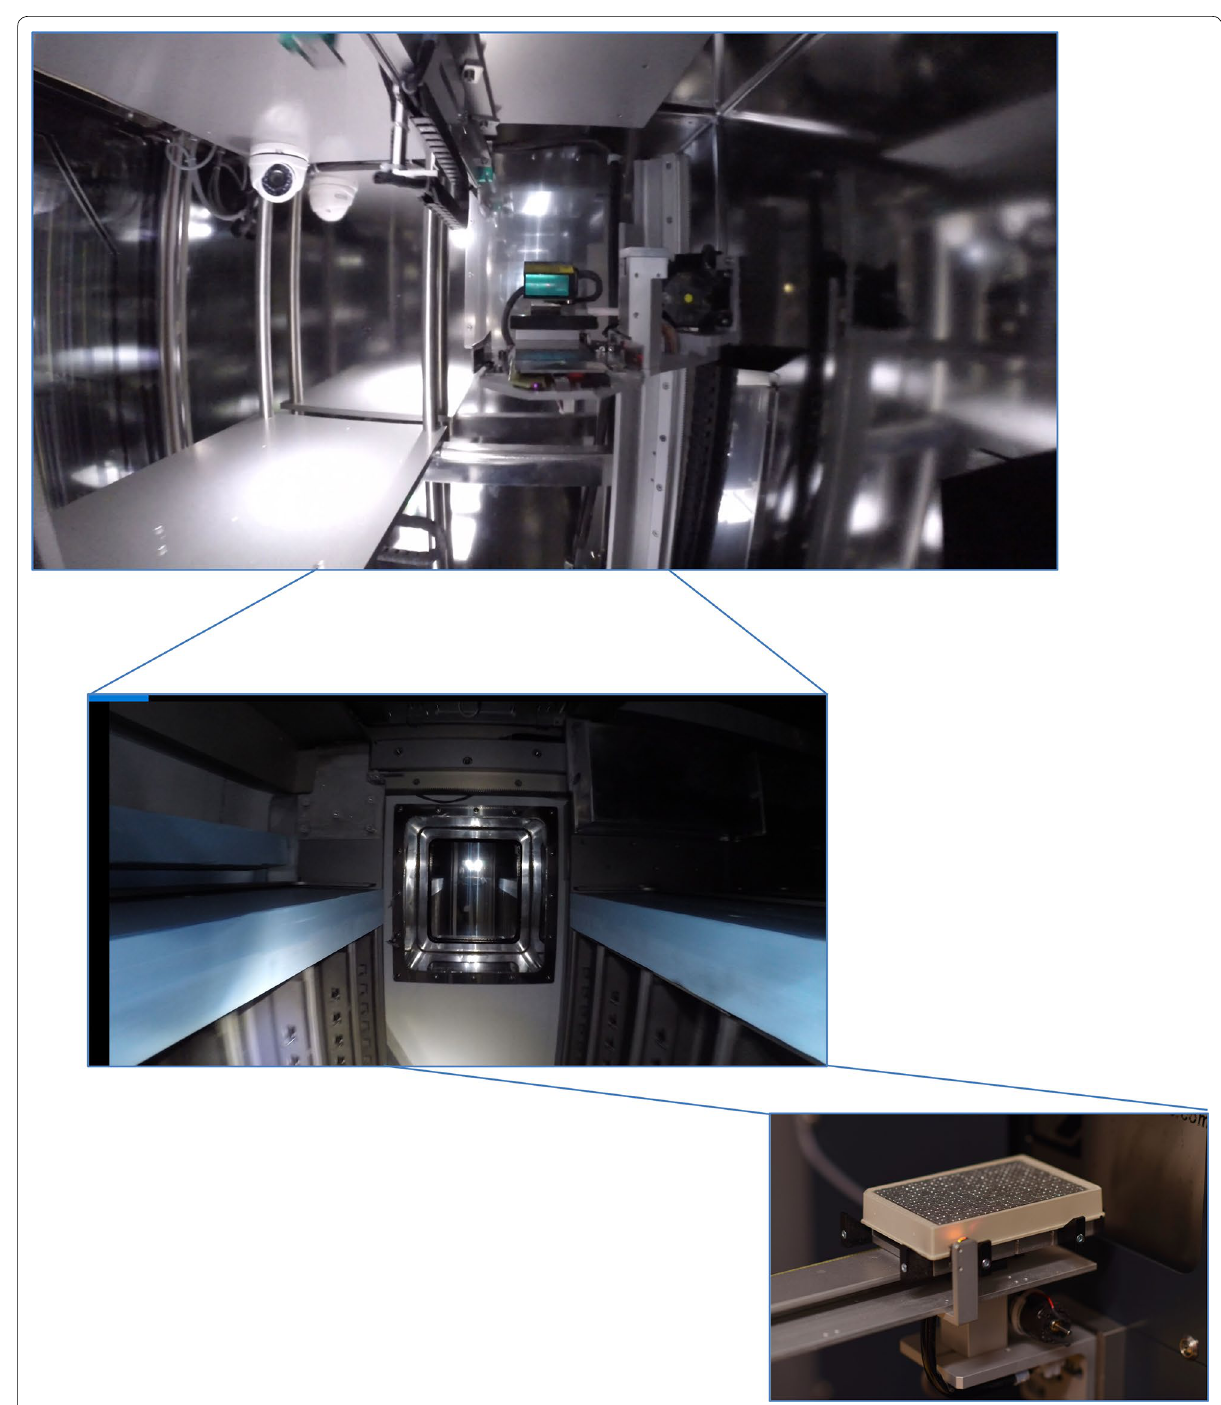
Fig. 4 The fully‑automated robotics of the biobank is shown; the heart of the robotic entry point is shown in the upper image; whilst the upper view of the robot is given in the central image. The lower image shows the automated biobank storage with the robotic 384‑sample tube plate entering the 80 °C −